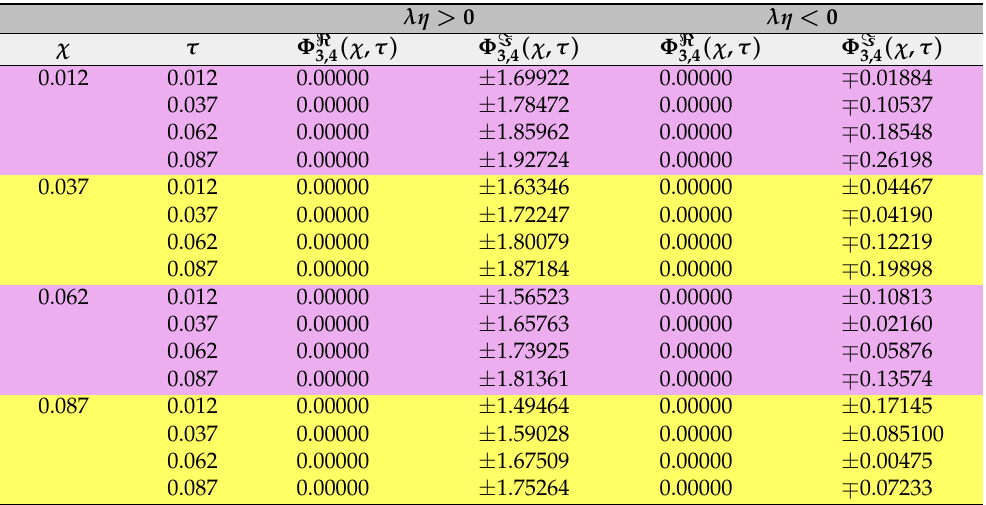
Table 2. The imaginary and real parts of the analytical solutions of Equation (4) are obtained by the G (cid:48) -expansion method, with diverse point sources, though arbitrary, and α = 0.90. G 2